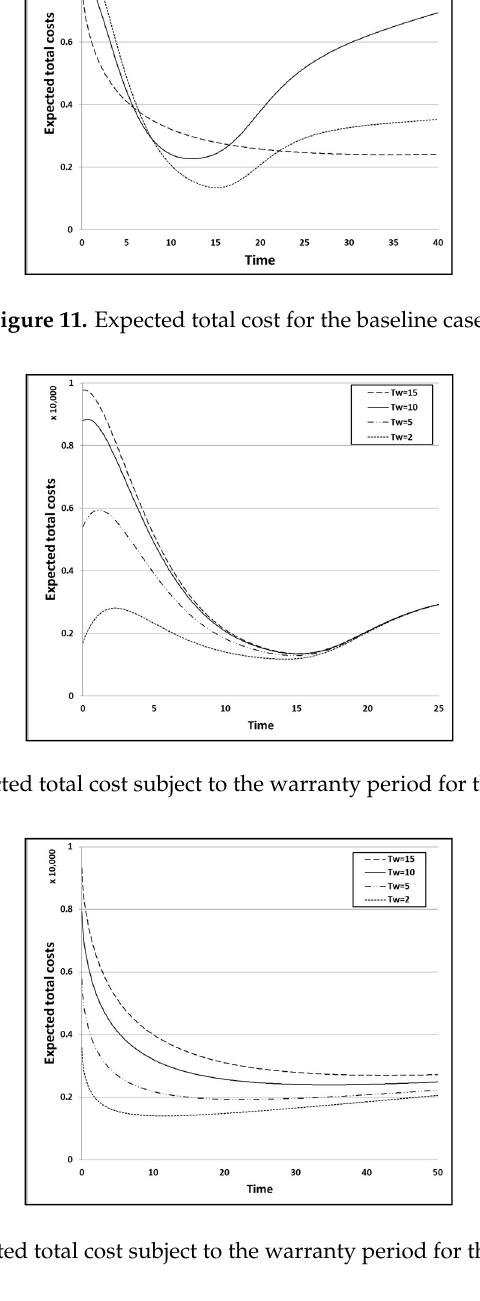
Figure 14. Expected total cost subject to the warranty period for the 3 rd condition.